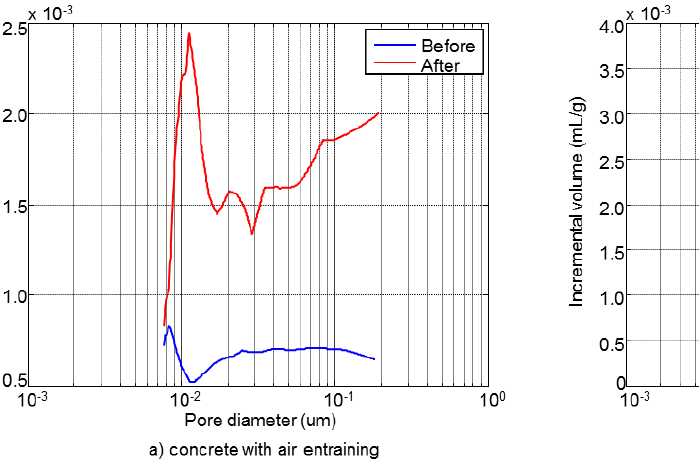
Figure 20. Pore size distribution of concrete obtained by